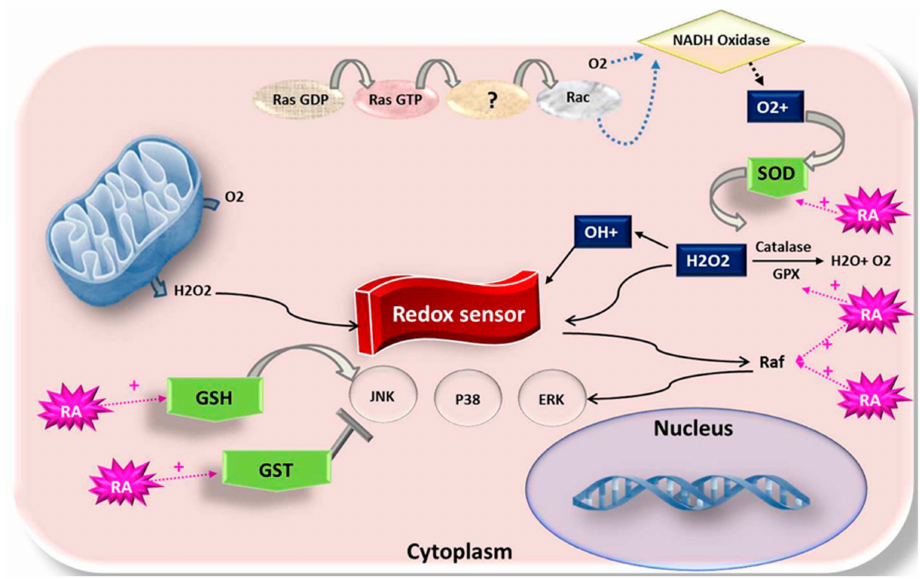
Figure 3. Schematic representation of the redox pathway and the mechanism of action of retinoids in the cytoplasm during